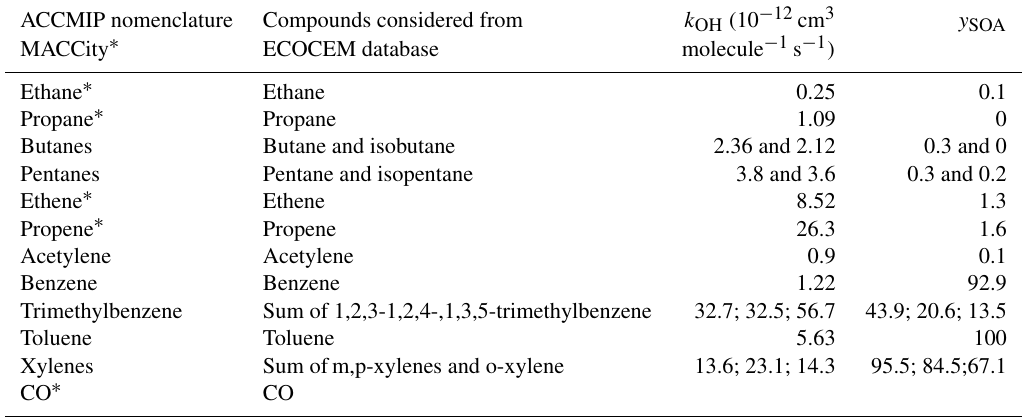
Table 3. List of target species and their k OH (Atkinson and Arey, 2003; Atkinson, 2007) and y SOA (SOA formation potential) (Derwent et al.,